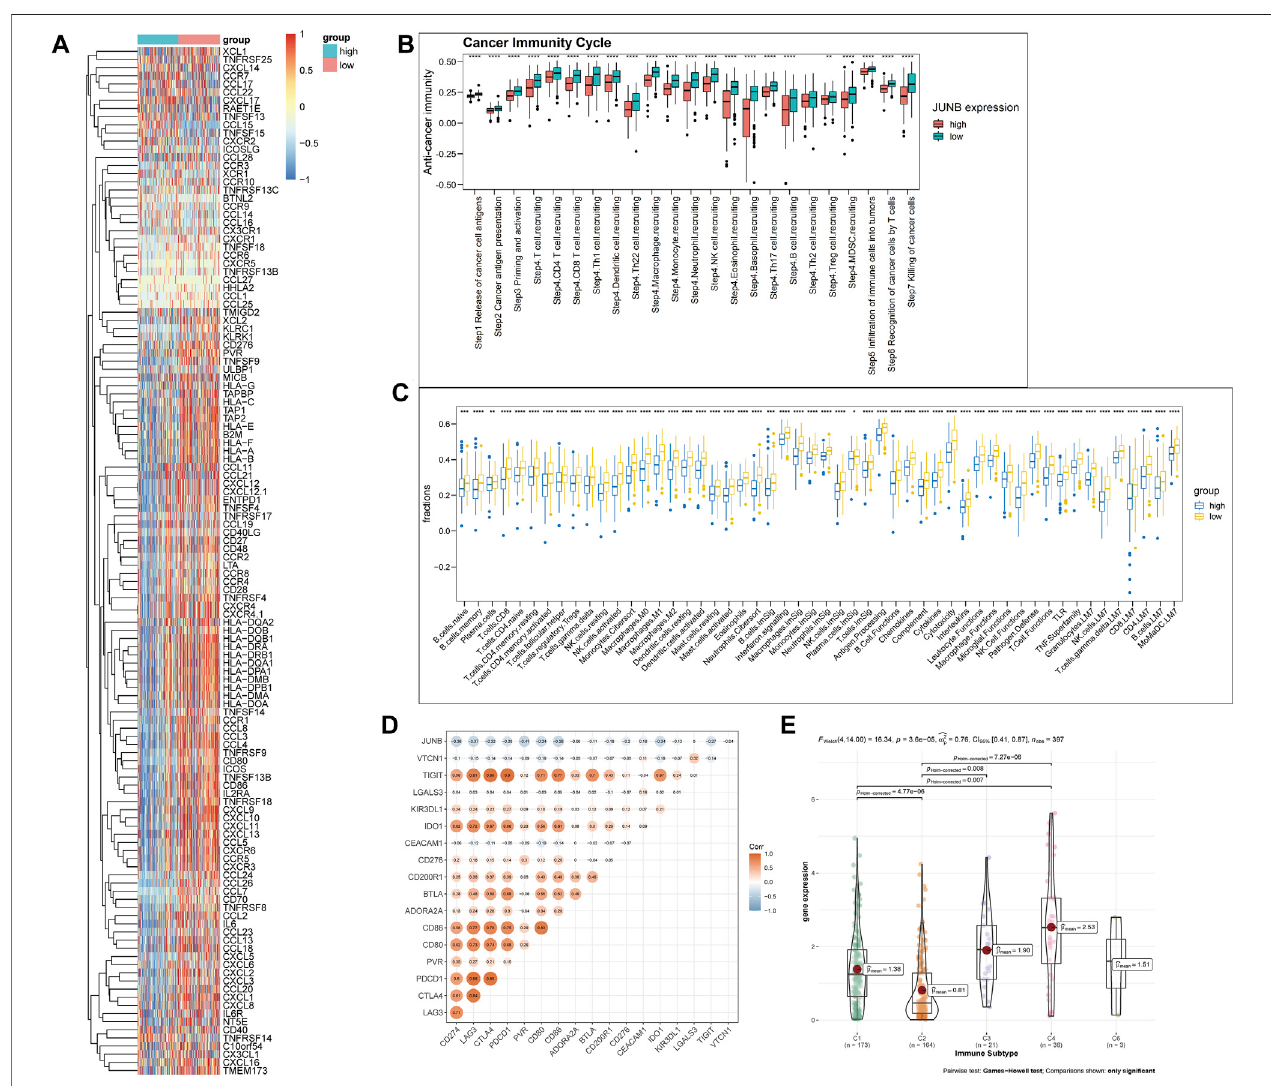
FIGURE4| JUNBshapedanon-in fl amedTMEandpredictedanon-sensitiveresponsetoICIstreatment. (A) Expressionofimmunostimulators,chemokines,MHC moleculesand receptors, (B) differences inanti-cancer immunitycycle,and (C) differences inin fi ltration levelsofimmunecells betweenhigh- andlow-JUNB groups. (D) Correlation between the expression of JUNB and immune checkpoint inhibitors. (E) The expression of JUNB across immune subtypes.